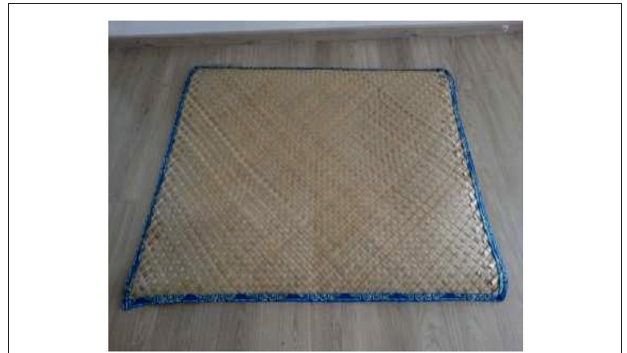
FIGURE 3 | The small braided mat of Pandanus used for object A in the KCK condition.